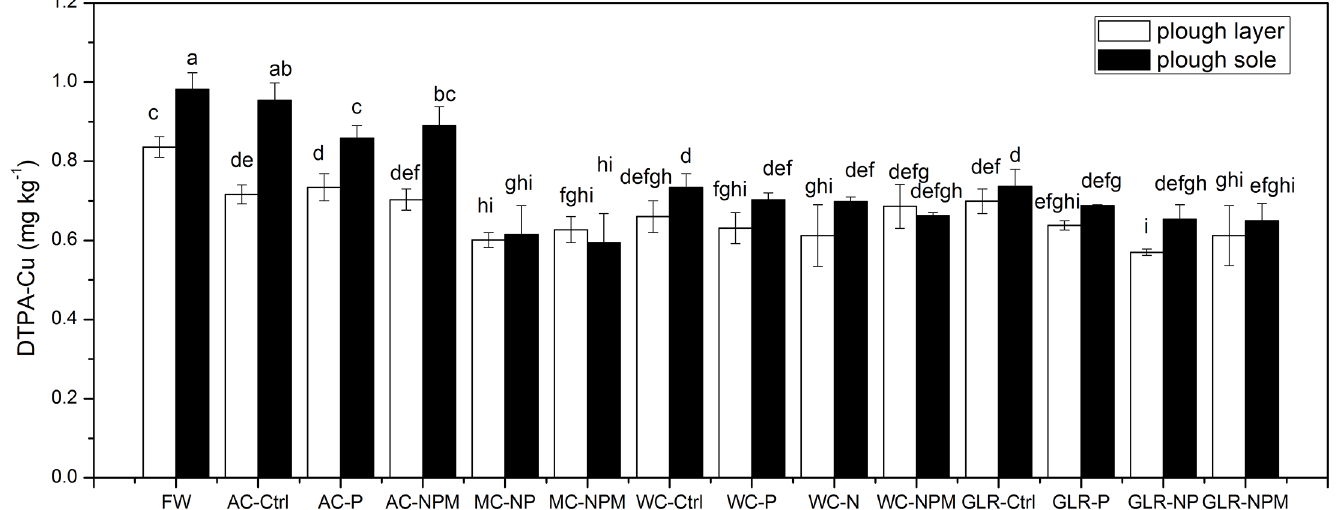
Fig 1. Soil DTPA-Cu concentrations in cropping systems with fertilization treatments. Different letters indicate a significant difference at p < 0.05. Error bars represent standard errors of the mean ( n = 3 ). Cropping systems: FW, fallow control; AC, continuous alfalfa; MC, continuous maize; WC, continuous winter wheat; GLR, grain-legume rotation. Fertiliser treatments: Ctrl, unfertilised control; N, nitrogen; P, phosphorus; NP, N + P; NPM, N + P + manure.